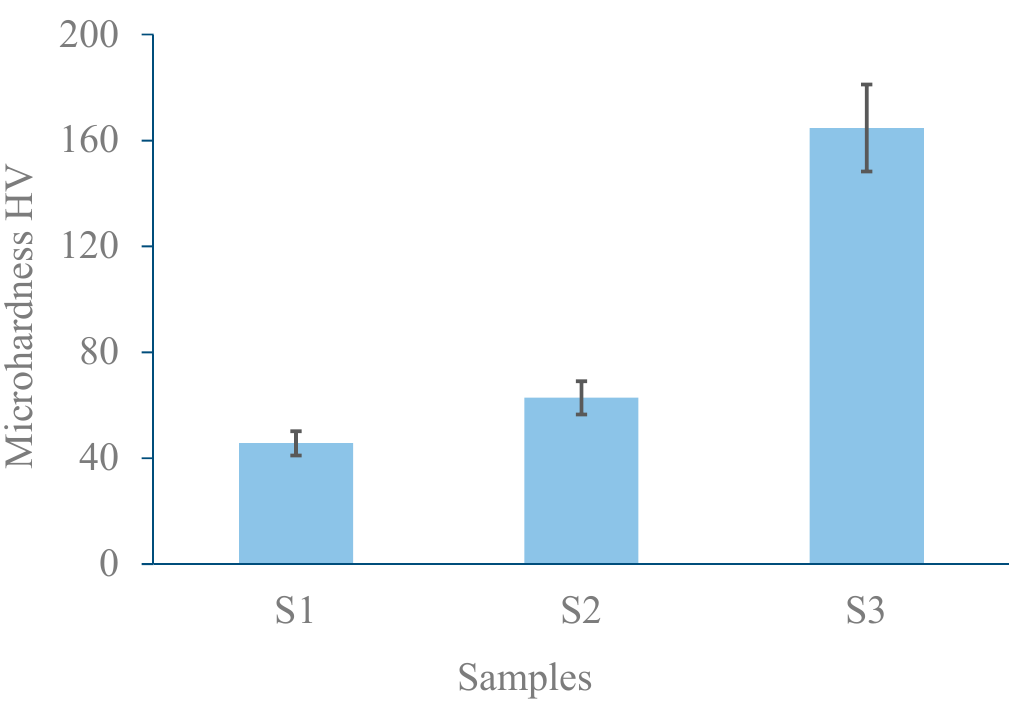
Figure 10. Microhardness results.